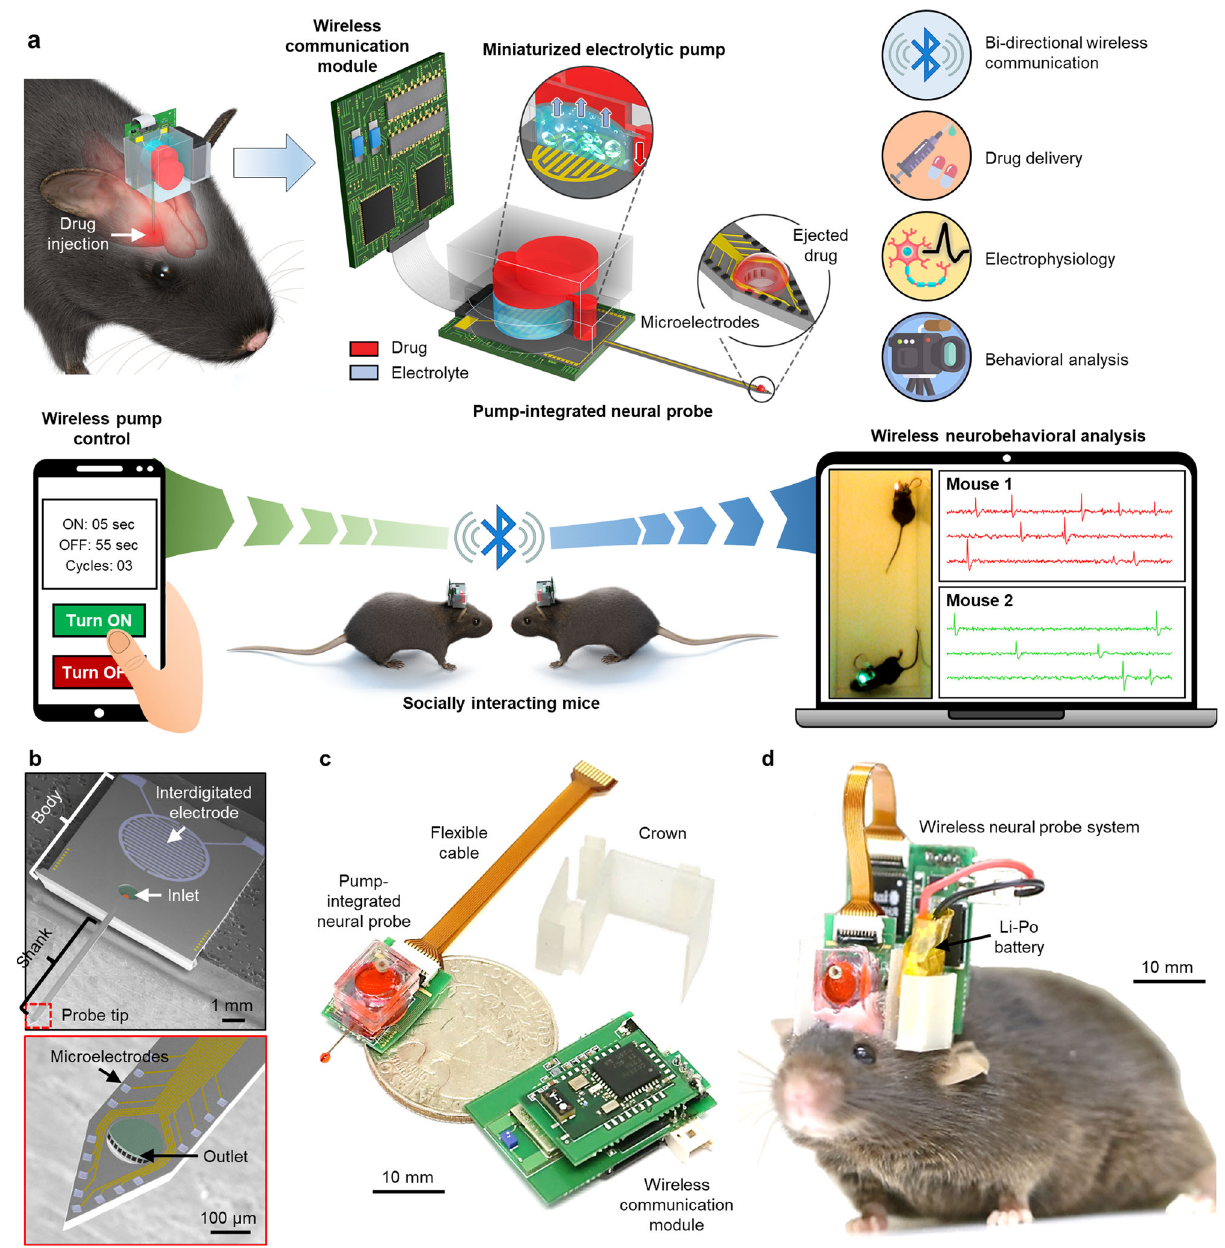
Fig. 1 | Design and features of the wireless neural probe system with drug delivery capability. a Schematic illustrations of the wireless neural probe system and its capabilities for behavioral neuropharmacology. b Scanning electron microscope (SEM) image of the neural probe showing the interdigitated electrode